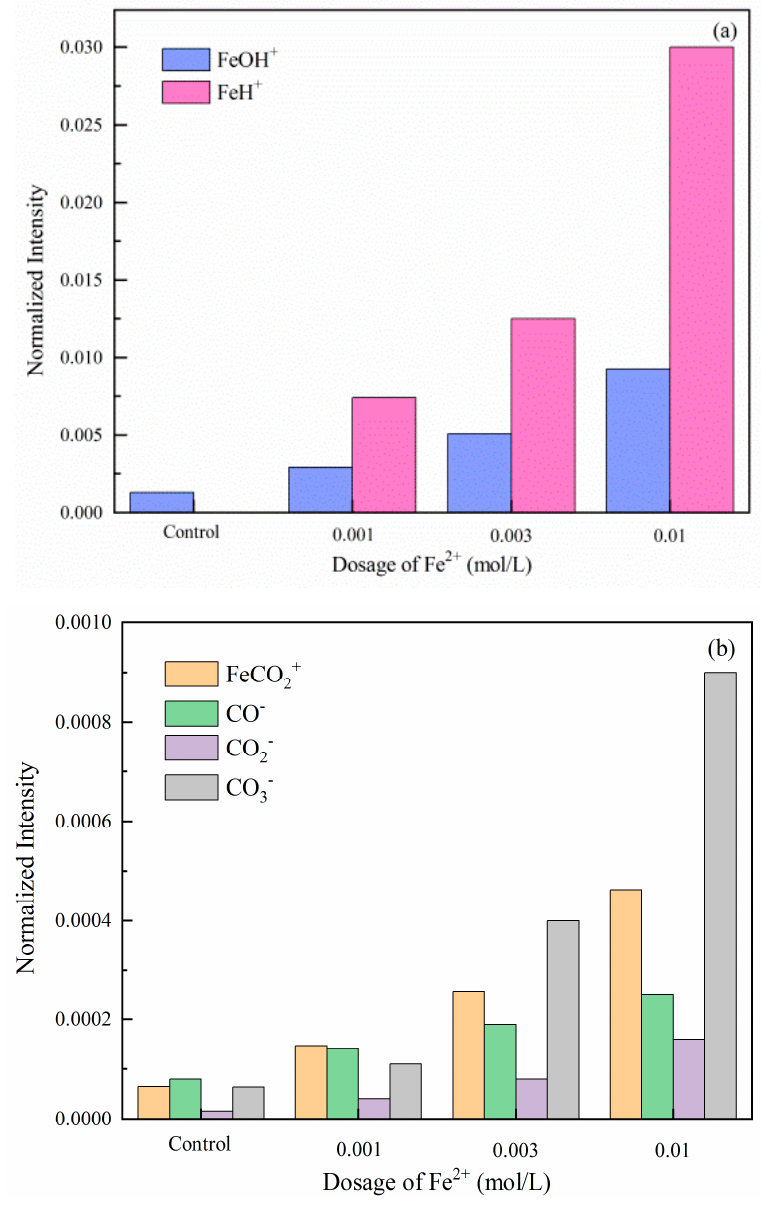
Figure 5. Normalized intensities of Fe-containing species (( a ) FeOH + and FeH + ; ( b ) FeCO 2+ , CO − , CO 2 − and CO 3 − ) (positive and negative secondary ions) on dolomite surfaces treated with Fe 2+ (pH = 8.5).